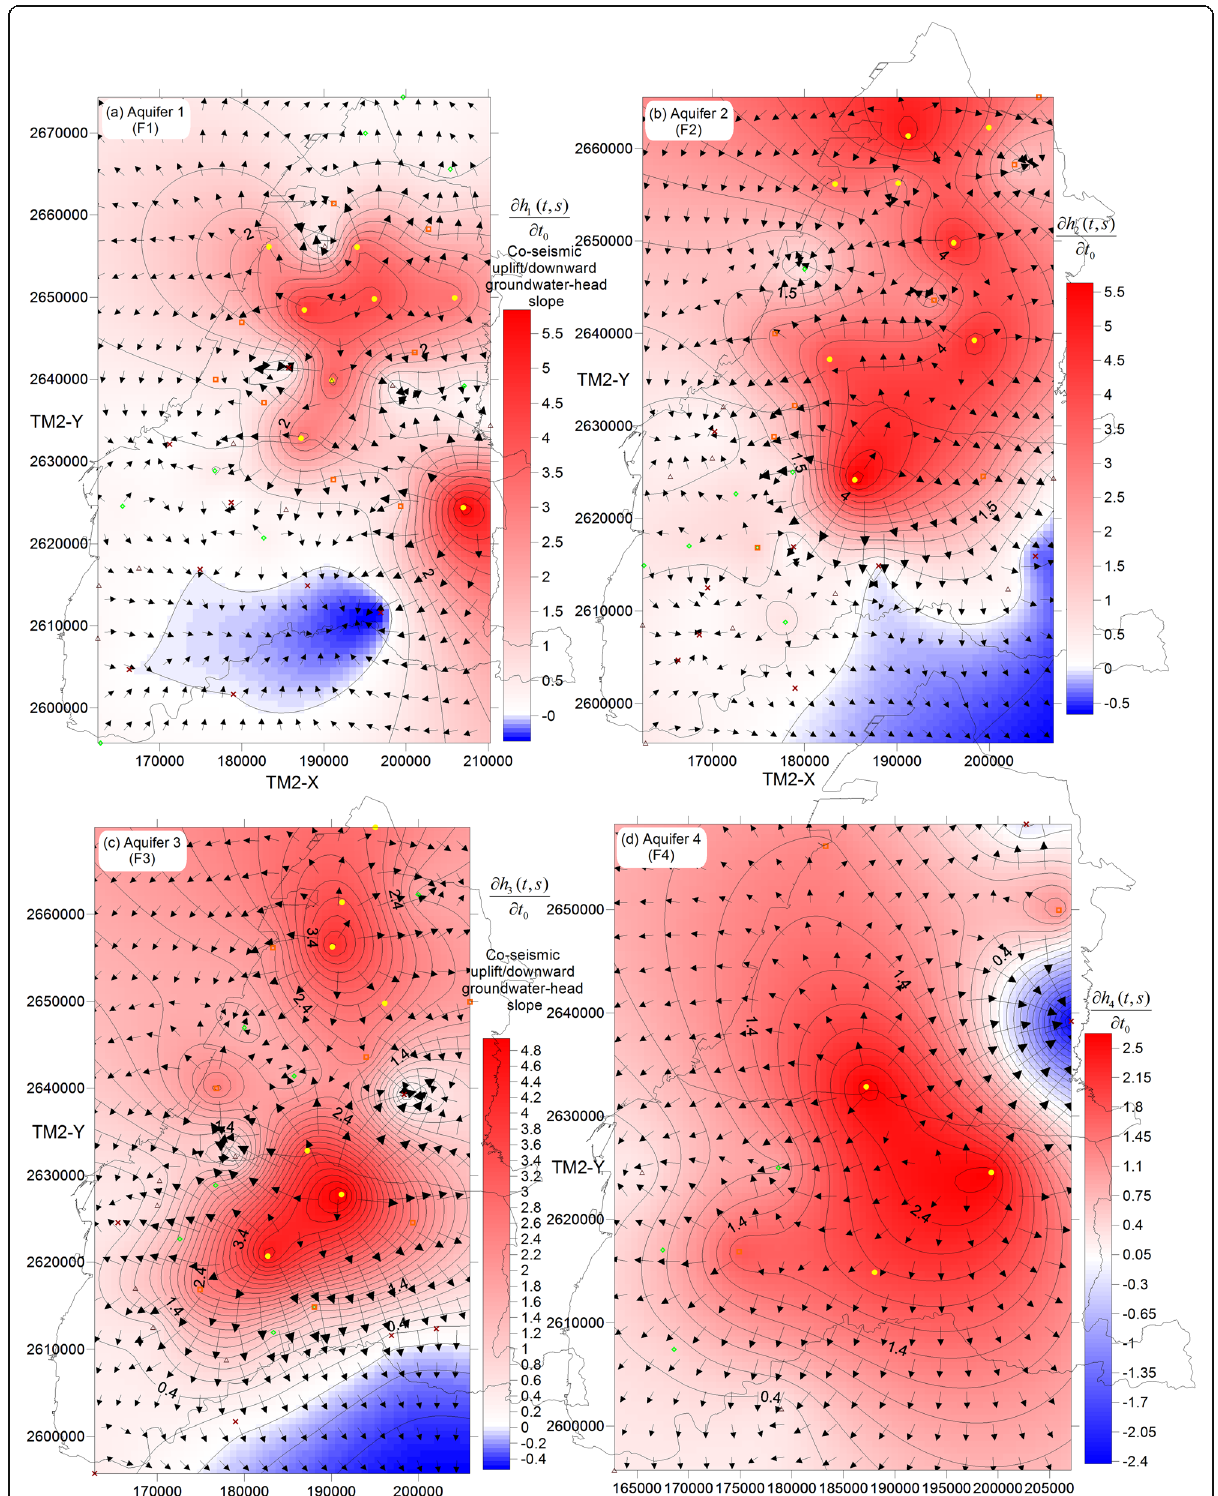
Fig. 8 Spatial changing patterns in co-seismic groundwater head across a aquifer 1, b aquifer 2, c aquifer 3, and d aquifer